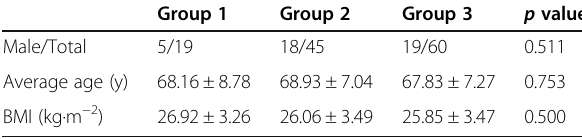
Table 1 The baseline characteristics of the